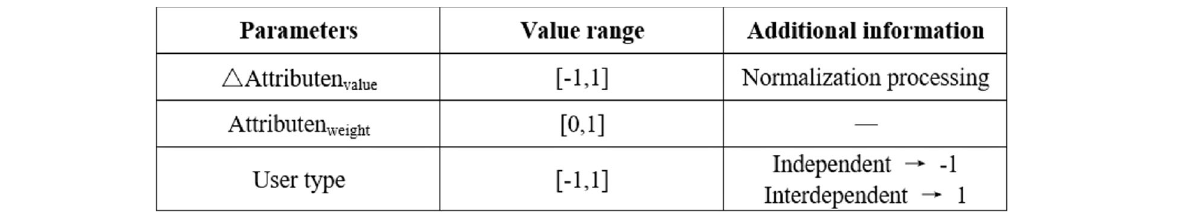
Table 6 Parameter settings of users